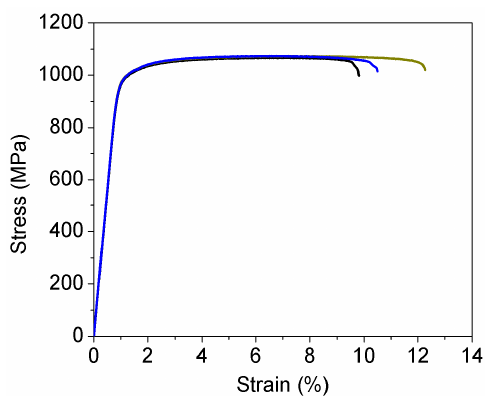
Figure 1. Relation of stress and strain under tensile test, in which the colors of the line denote different specimens.